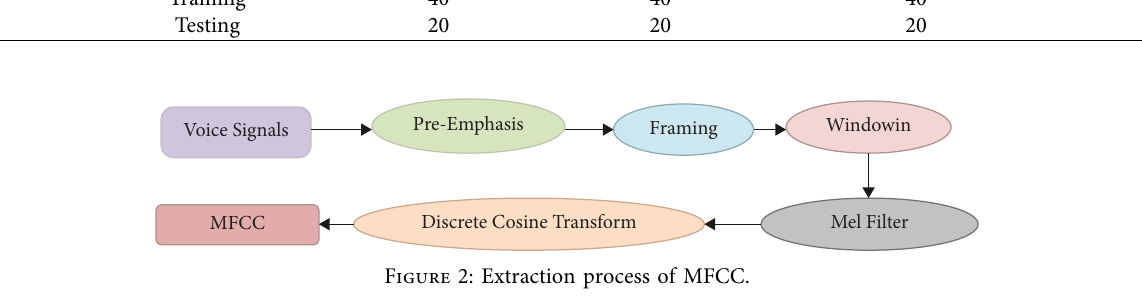
Figure 2: Extraction process of